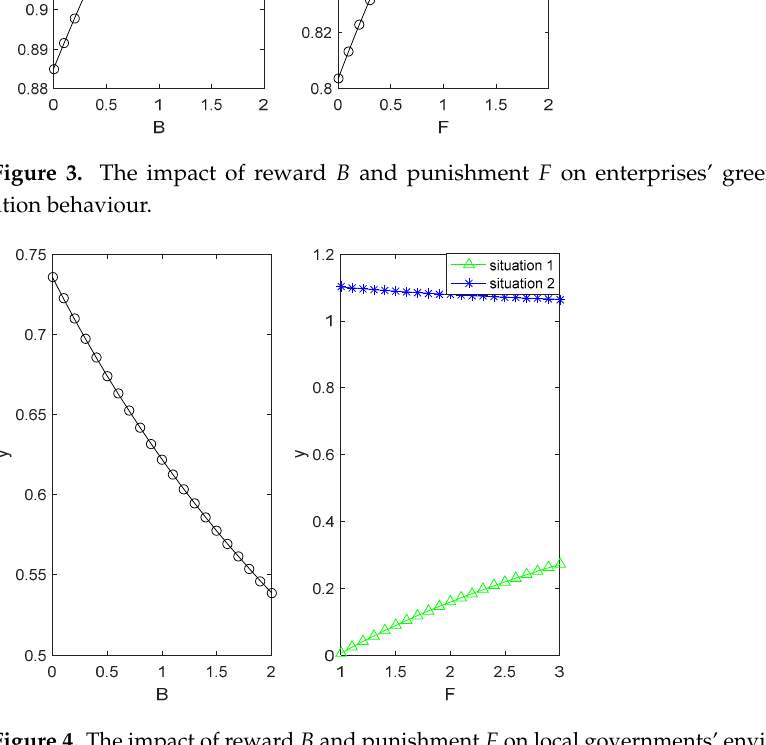
Figure 4. The impact of reward B and punishment F on local governments’ environmental regulation strategy supervision behaviour.